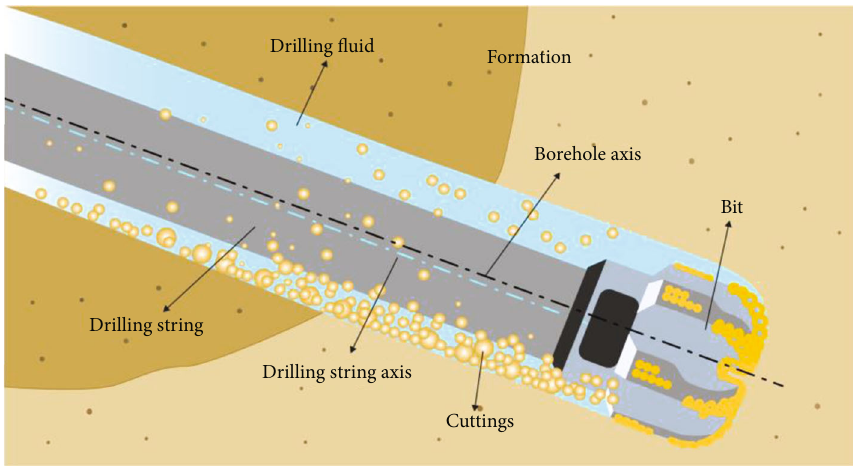
Figure 1: Schematic diagram of cuttings migration in the horizontal